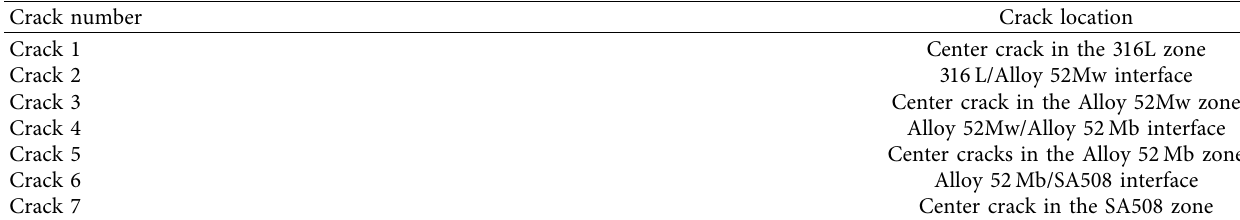
Figure 2: (a) The DMWJ structure for connecting the pipe-nozzle of a pressure vessel to the safe-end and (b) the four materials composed of the DMWJ (pipe-nozzle A508, buttering Alloy52Mb, weld Alloy52Mw, and safe-end pipe 316L). Table 1: A summary of the seven cracks and their locations.